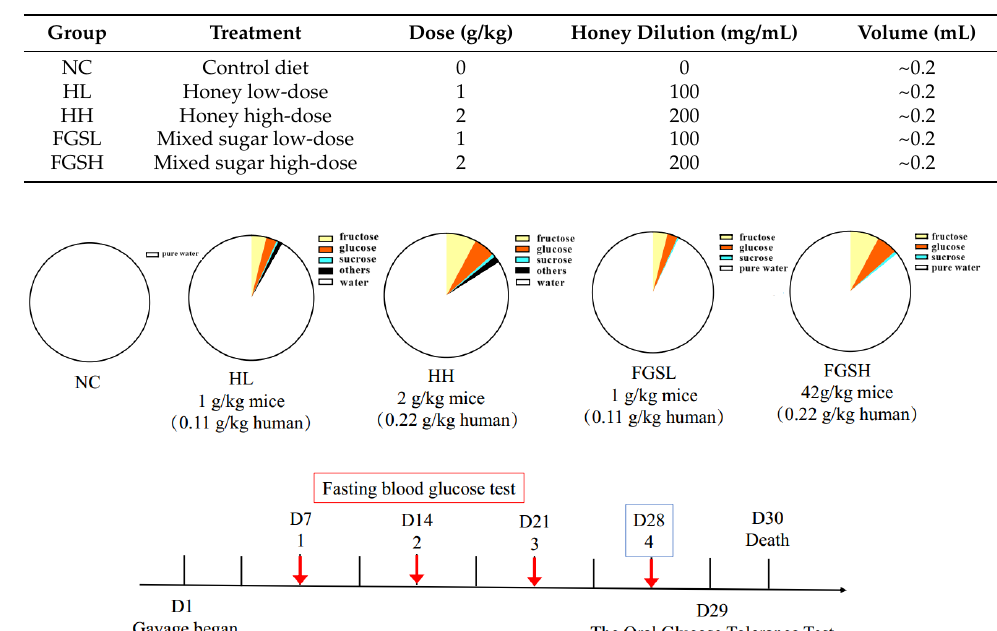
Figure 1. Timeline of events and experimental design used.